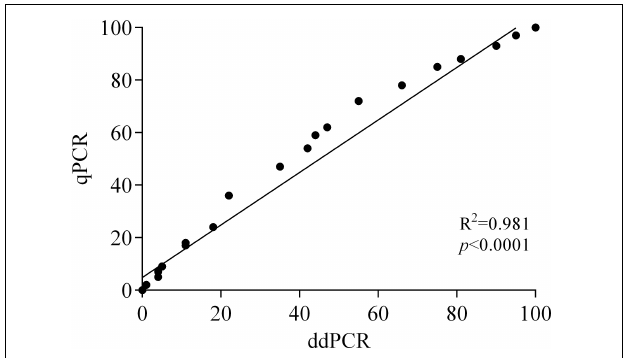
FIGURE 4 | Correlation between ddPCR and qPCR data of Monilinia fructicola vs. Monilinia laxa ratios in artificially inoculated fruits of apricot and